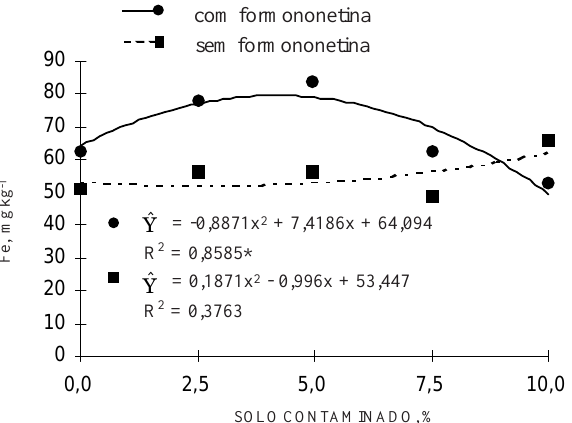
Figura 4. Teor de Fe na matéria seca da parte aérea do milho em função da proporção de solo contaminado com metais pesados e aplicação da